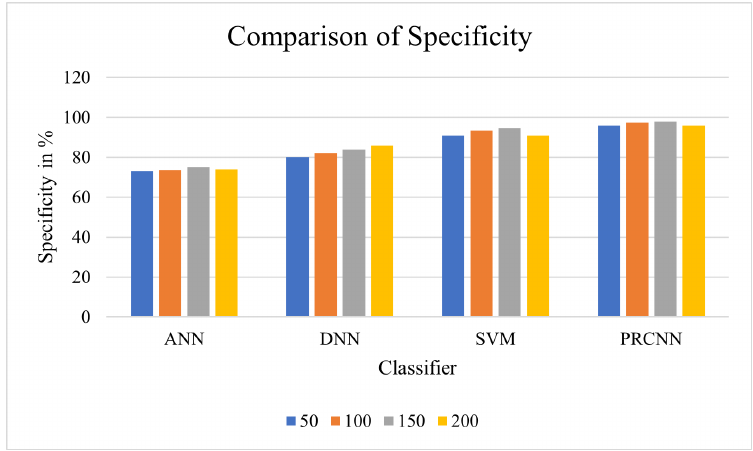
Figure 9. Comparison of